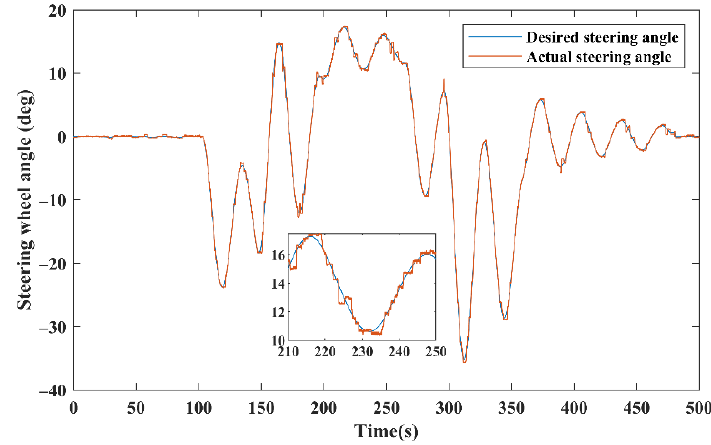
Figure 13. The steering angle tracking effect when driving on flat terrain.